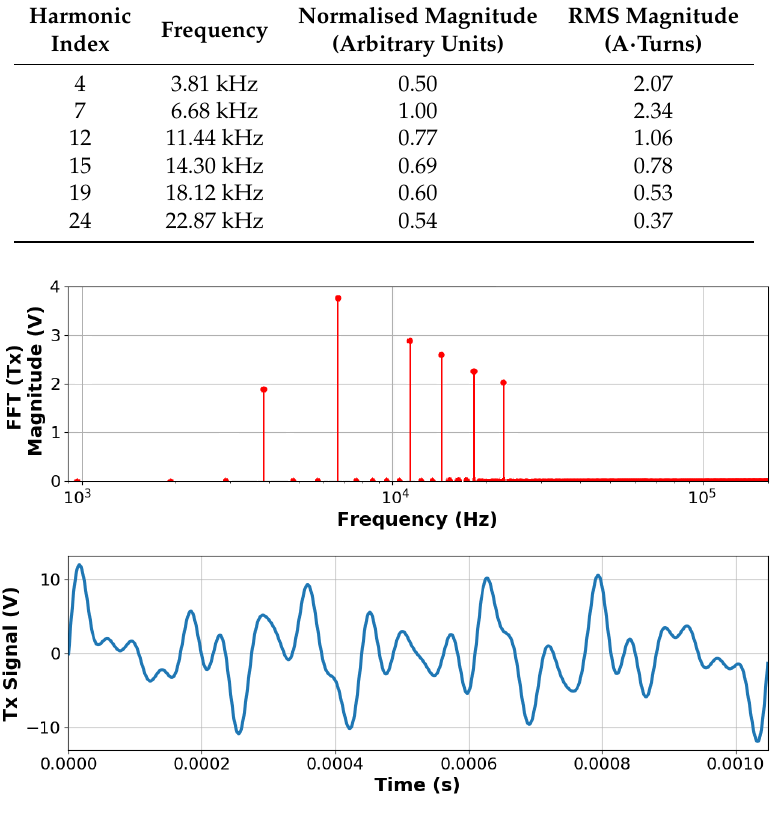
Figure 4. Transmit signal characteristics for MIS